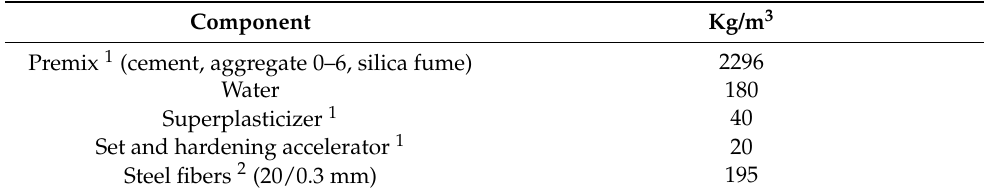
Table 1. Components in UHPC.